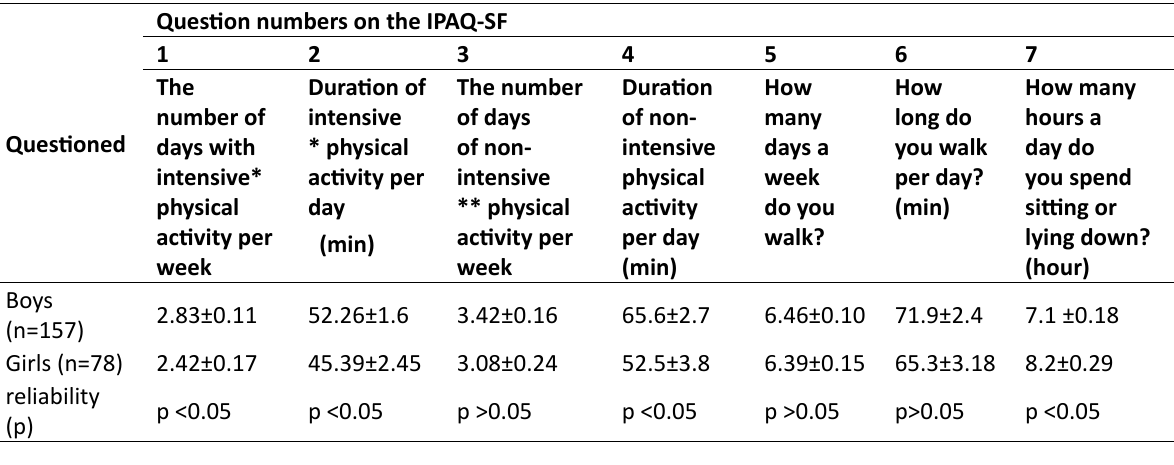
Table 2. Student questionnaire results by the IPAQ-SF questionnaire (M ± m)